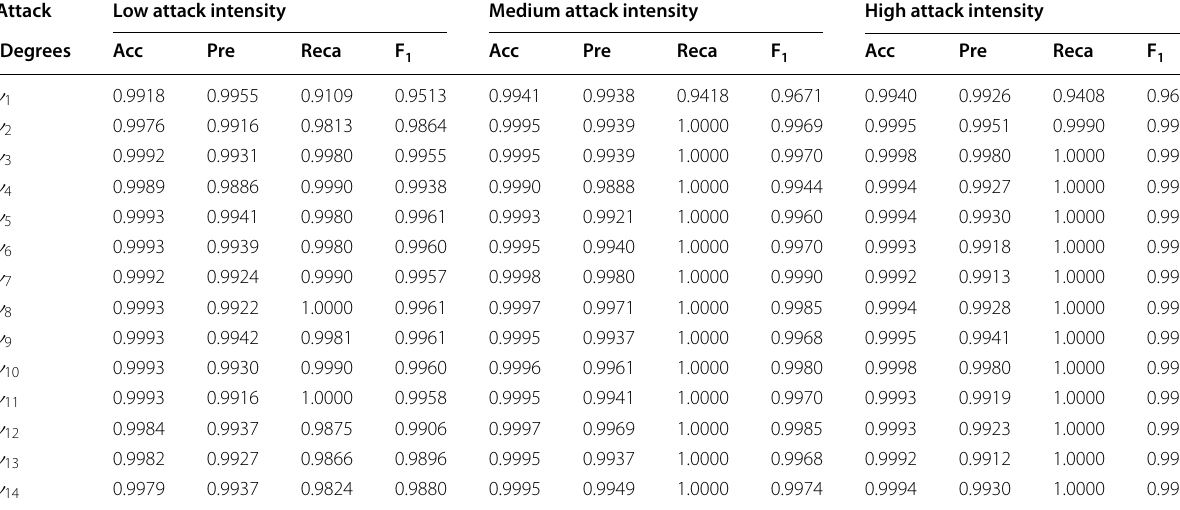
Table 3 Detection Results of Different Attack Intensities and Attack Degrees Attack Low attack intensity Medium attack intensity High attack intensity